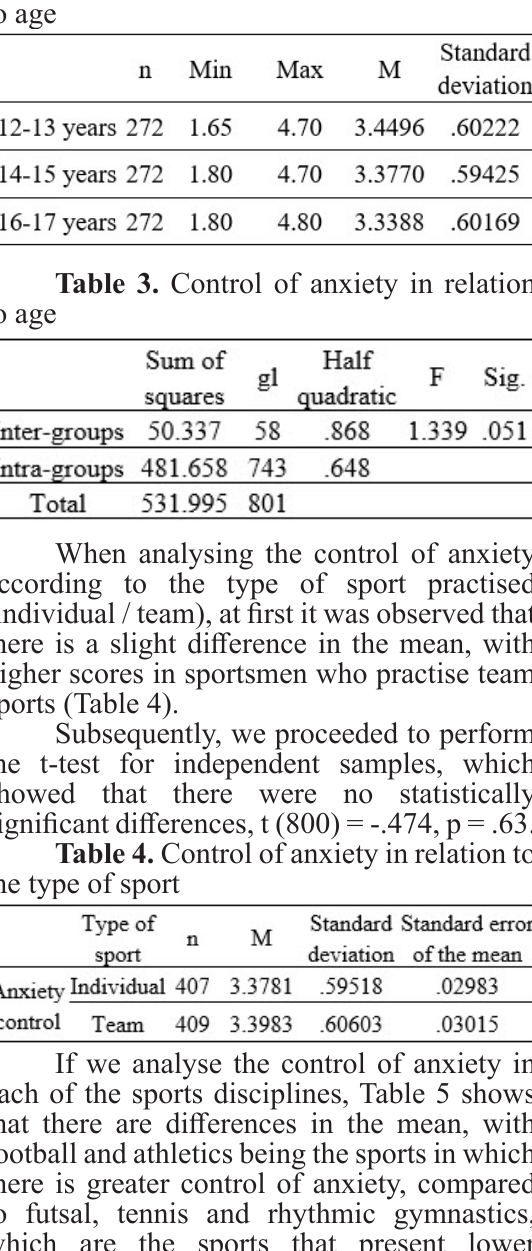
Table 2. Control of anxiety in relation